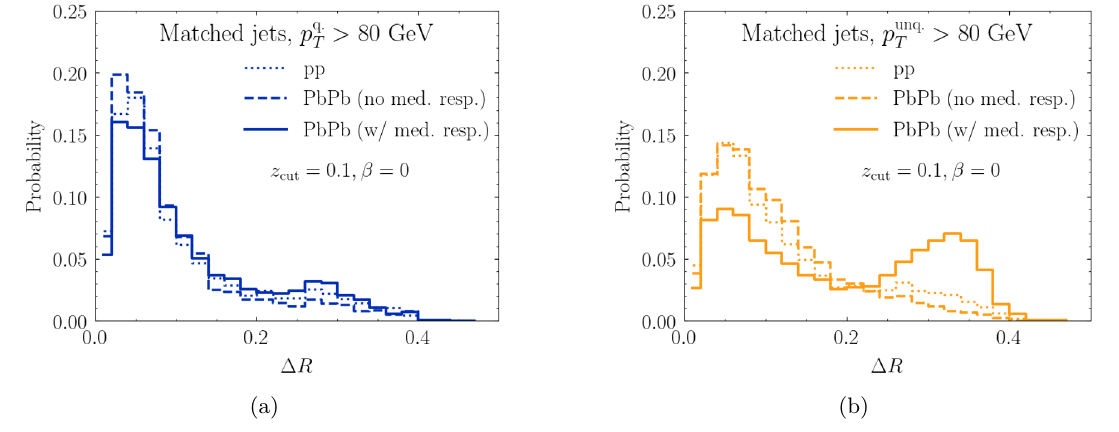
Figure 2. (a) ∆ R distributions for a sample of jets selected on the basis of having quenched p T above 80 GeV (solid and dashed blue) and the matching unquenched jets (dotted blue). Each quenched jet was matched to the unquenched jet that it would have been if it had formed in vacuum. (b) ∆ R distributions for a sample of jets selected on the basis of having unquenched p T above 80 GeV (dotted orange) and the matching quenched jets (solid and dashed orange). Dashed curves are for jets quenched as in a heavy ion collision with hadrons originating from medium response artificially excluded; solid curves are for quenched jets including those hadrons from medium response that are reconstructed as a part of the